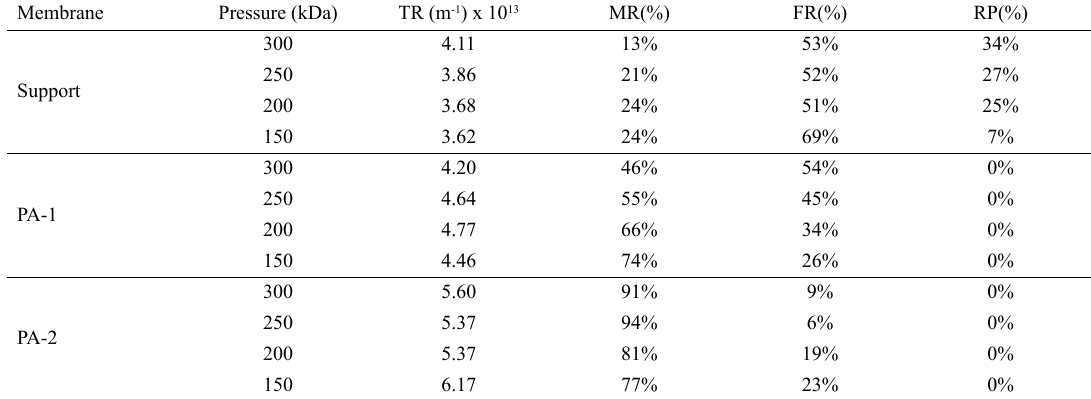
Table 3. Percentage contribution of each type of obstruction with oil concentration of 100 mg∙L -1 .